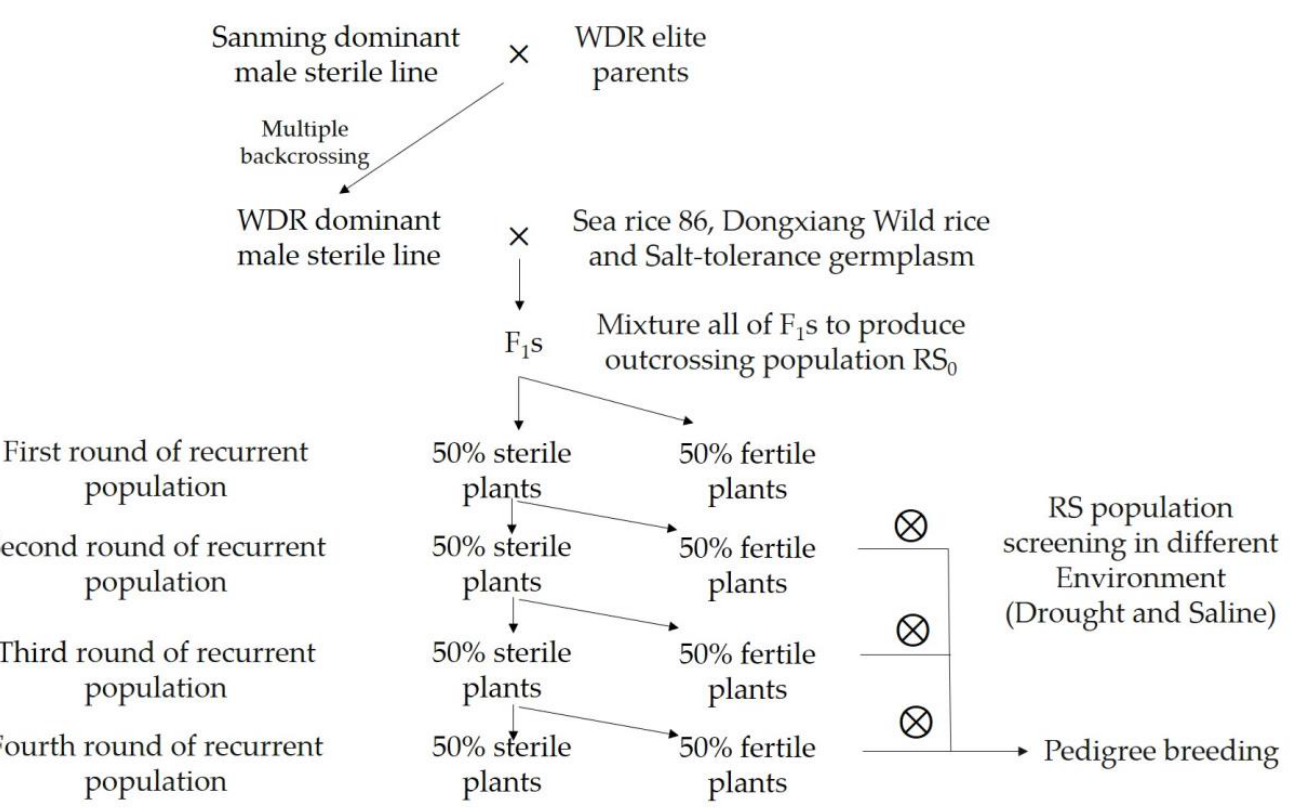
Figure 2. Improvement salt resistance of WDR by dominant male sterile recurrent selection popu- lation.